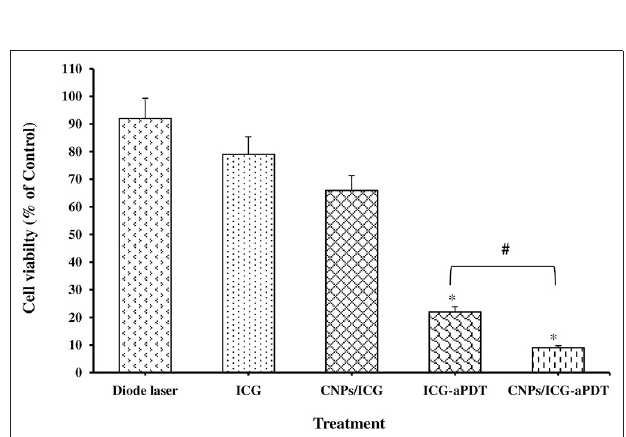
FIGURE 4 | Percent of Aggregatibacter actinomycetemcomitans viability after exposed with test groups. Results are represented as mean ± standard error of the mean. *Significant difference from control ( P < 0.05). # Significant difference between ICG-aPDT and CNPs/ICG-aPDT.